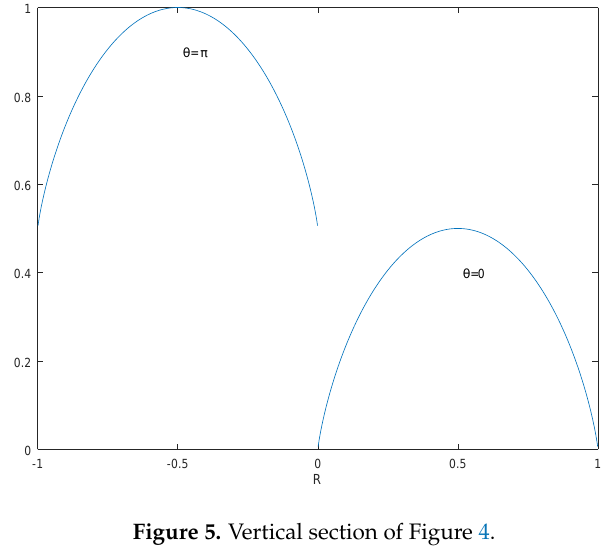
Figure 4. Contour plot of the entropy calculated from Equation (6).